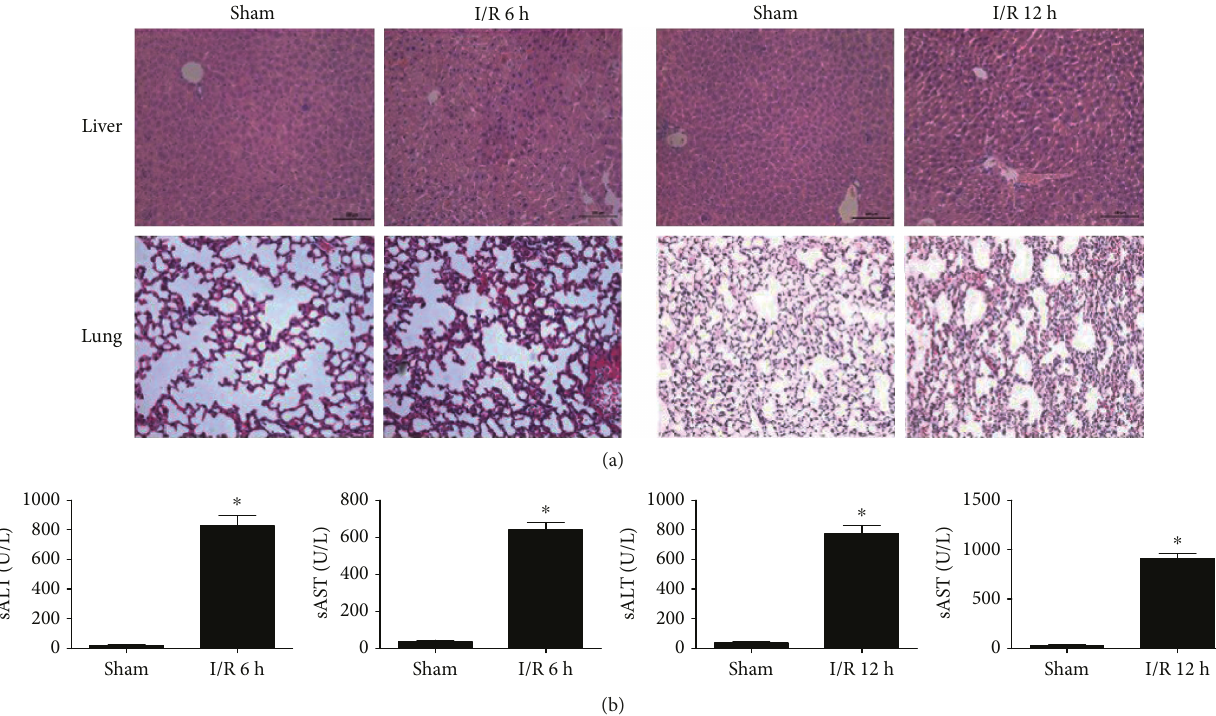
Figure 1: Liver I/R leads to local hepatic and remote lung injury. Liver and lung sections stained with H&E after liver reperfusion at 6 h or 12h (a).ConcentrationsofASTandALTwere detectedfollowingliver reperfusion at6 hor12 h(b). GraphPadvaluesarepresented asmean ± SEM. ∗ P < 0 05 versus the Sham